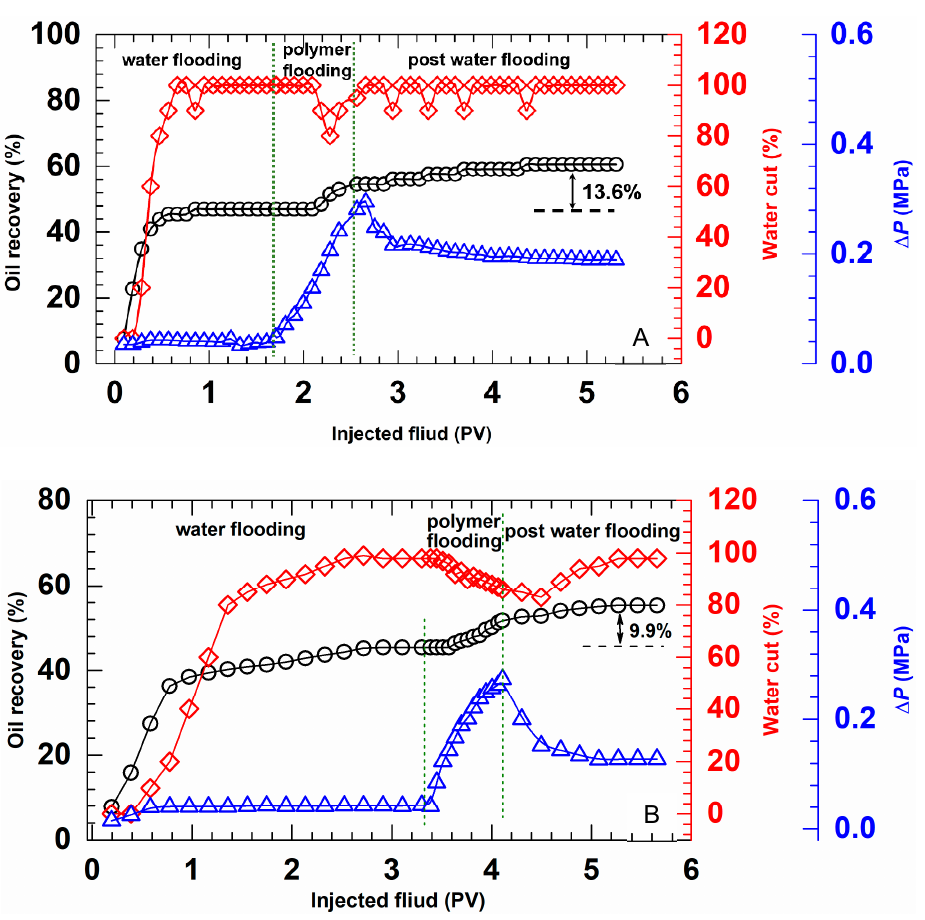
Figure 7. Variation in pressure and oil recovery factor for ( A ) TVP and ( B ) HPAM solutions during core flooding at 45 ◦ C. The 0.5% mother polymer solutions were prepared with 4500 mg/L synthetic produced fluid containing 65 mg/L Ca 2+ and Mg 2+ , and then diluted to 0.1% polymer solution with the synthetic brine with TDS of 950 mg/L NaCl. Table 2. The core flooding results of 0.1% TVP and HPAM solutions at 45 ° C.